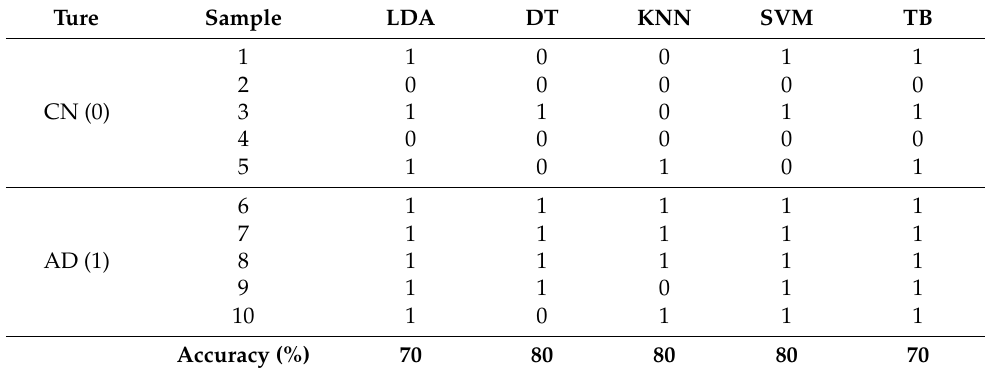
Table 4. Performance of the VAD Pause feature on a local dataset, using five machine-learning classifiers.